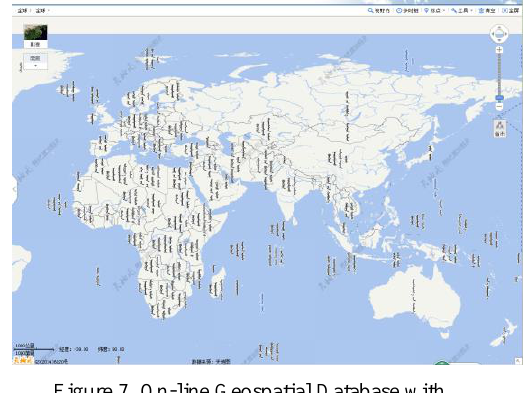
Figure 7. On-line Geospatial Database with Mongolian Place Names